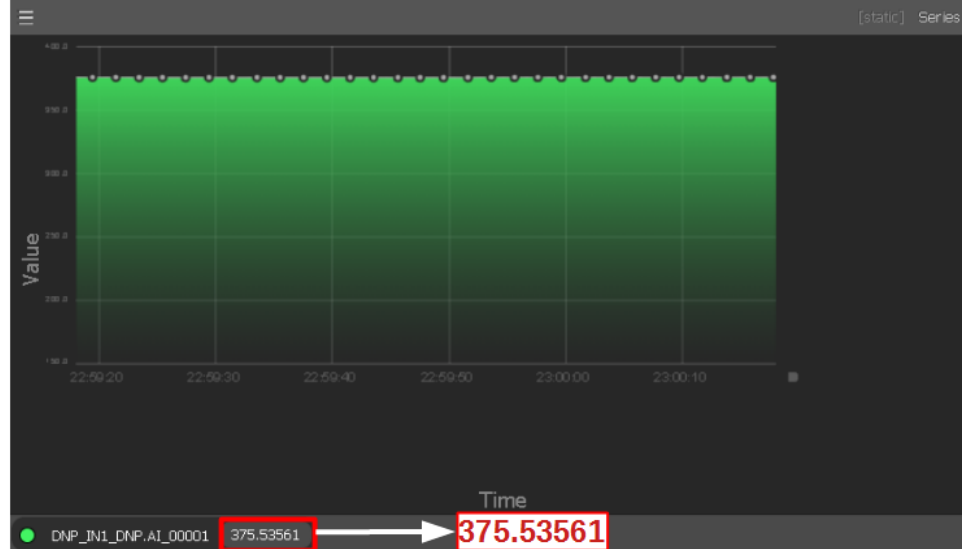
Figure 16. Real-time values of line–line Vrms (V) in HMI.